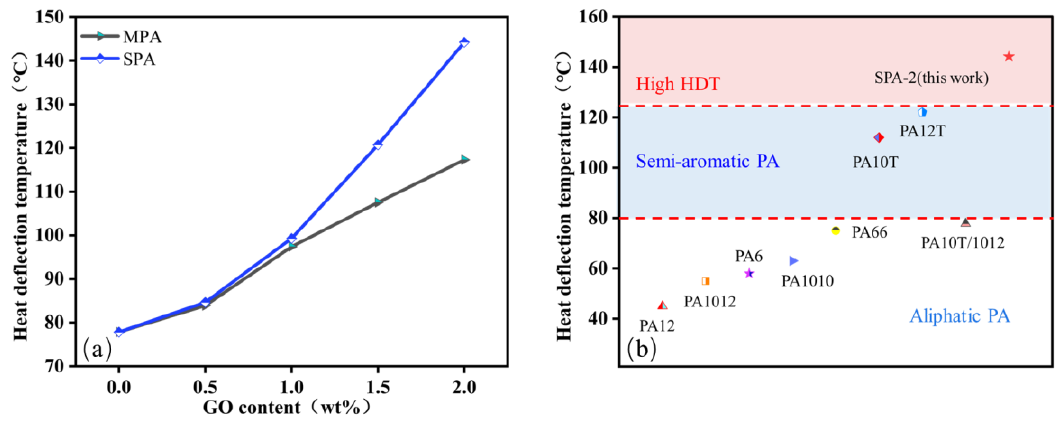
Figure 11. ( a ) Thermal deformation temperature curve of SPA composites and MPA composites; ( b ) Thermal deformation temperatures of SPA composites compared with other polyamides.